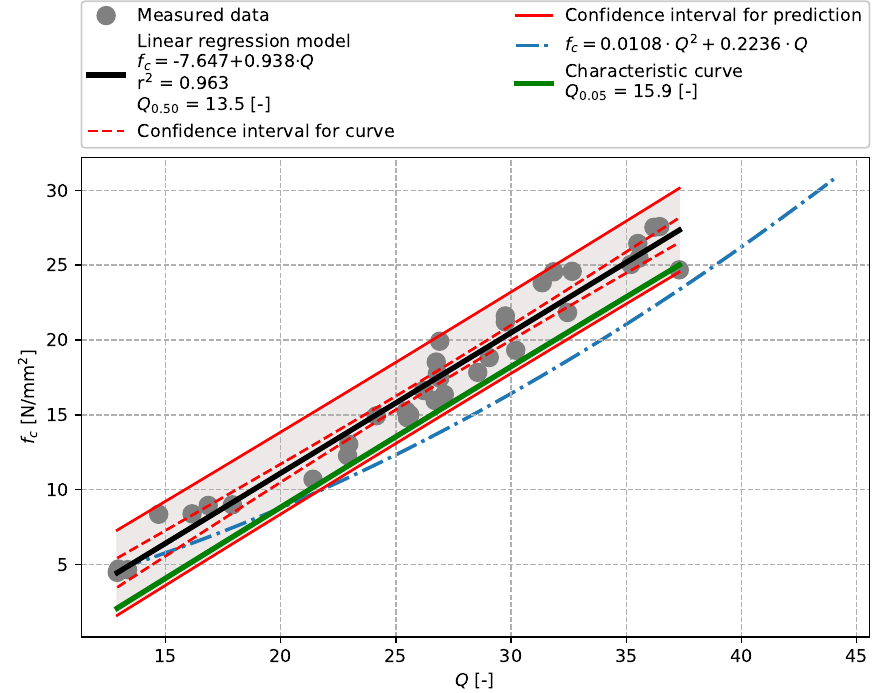
Figure 11. Precast concrete described in Section 3.3—model of the dependence of Q -value [-] vs. compressive strength f c [N/mm 2 ]—SilverSchmidt L –